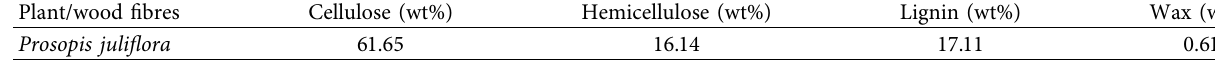
Table 1: Chemical confguration of Prosopis julifora natural wood fbers.